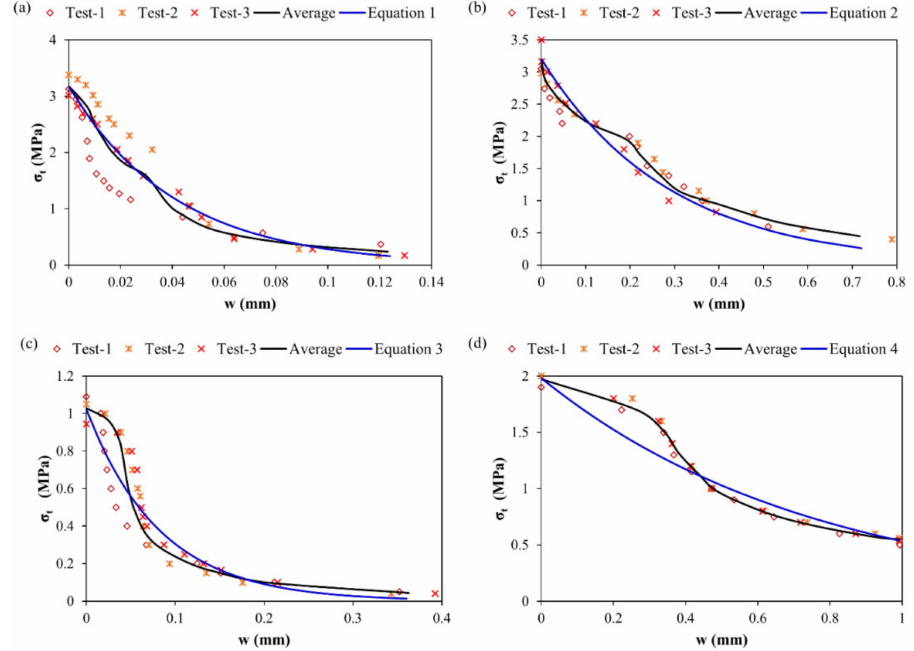
Figure 14. σ -w law for various composites ( a ) plain mortar, M0R0F ( b ) M0R30F ( c ) M30R0F ( d ) M30R30F.